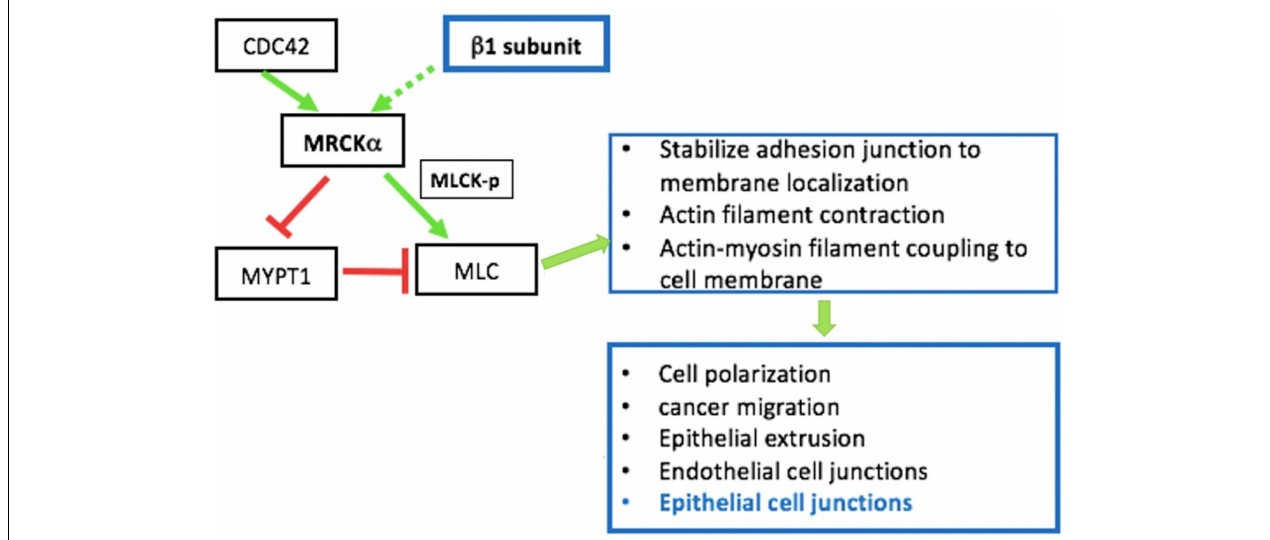
FIGURE 2 | MRCK α signaling pathway is involved in epithelial intercellular junction regulation. MRCK α is activated (solid green arrow) by cdc42, a Rho family of small GTPases. The MRCK α kinase activates myosin light chain (MLC) either by directly phosphorylating/activating (green arrow) myosin light chain kinase (MLCK) or by inactivating (red arrow) myosin phosphatase target subunit 1 (MYPT1), which dephosphorylates/ inactivates (red arrow) MLC. The two consecutive negative activities (red arrows) result in the indirect activation of MLC by reducing MLC dephosphorylation/ inactivation. These events regulate multiple cellular functions such as actin-myosin contraction, which is involved in epithelial junction regulation. In addition, our previous data indicate that overexpression of β 1- Na + , K + -ATPase increases activation/phosphorylation of MLC (Bai et al.,